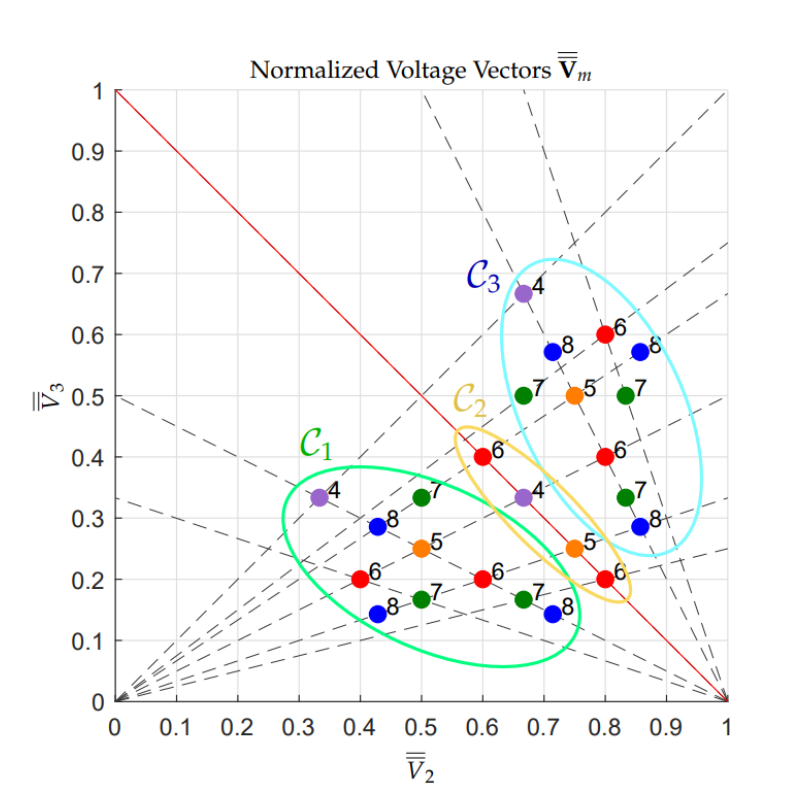
Table 3. All of the Configuration Voltage Vectors V m for the case n = 3 and m